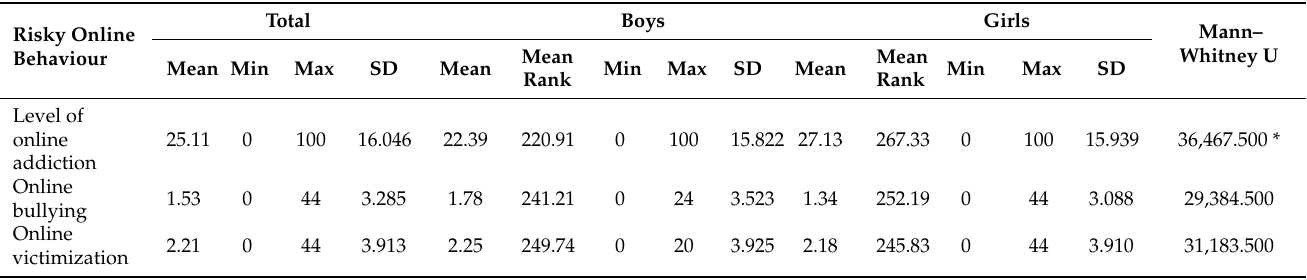
Table 4. Problematic usage of the Internet, by